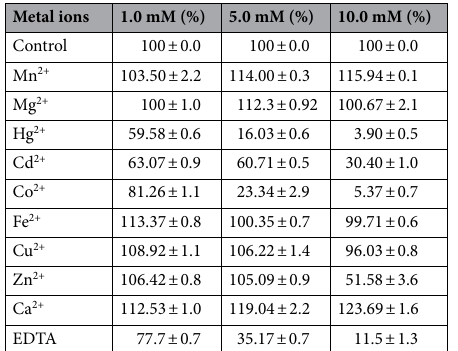
Table 2. Effect of metal ions and inhibitor on the activity of purified cold-active Apr-BO1 at three different concentrations. The values are the mean of three replicates ± standard deviation.